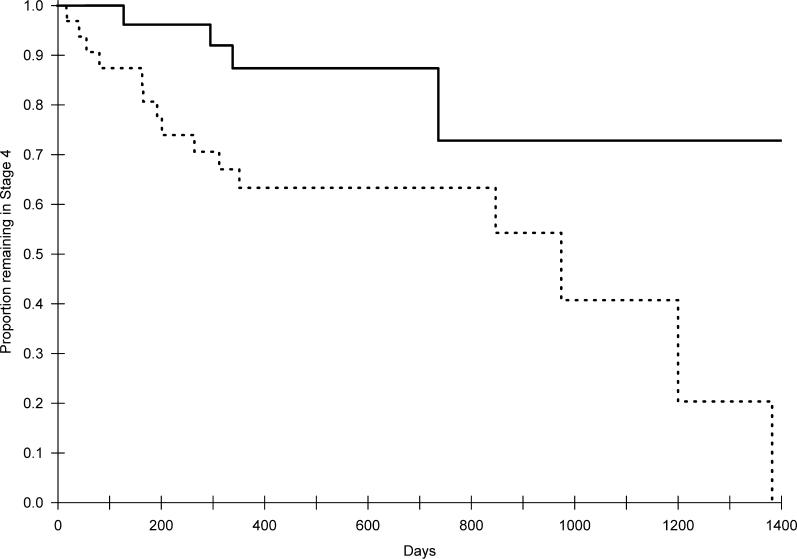
Progression of HIV-Infected Individuals from WHO Stage 4 for Patients on HAART and Not on ARTThe solid line indicates patients on HAART, and the dotted line indicates patients not on ART.